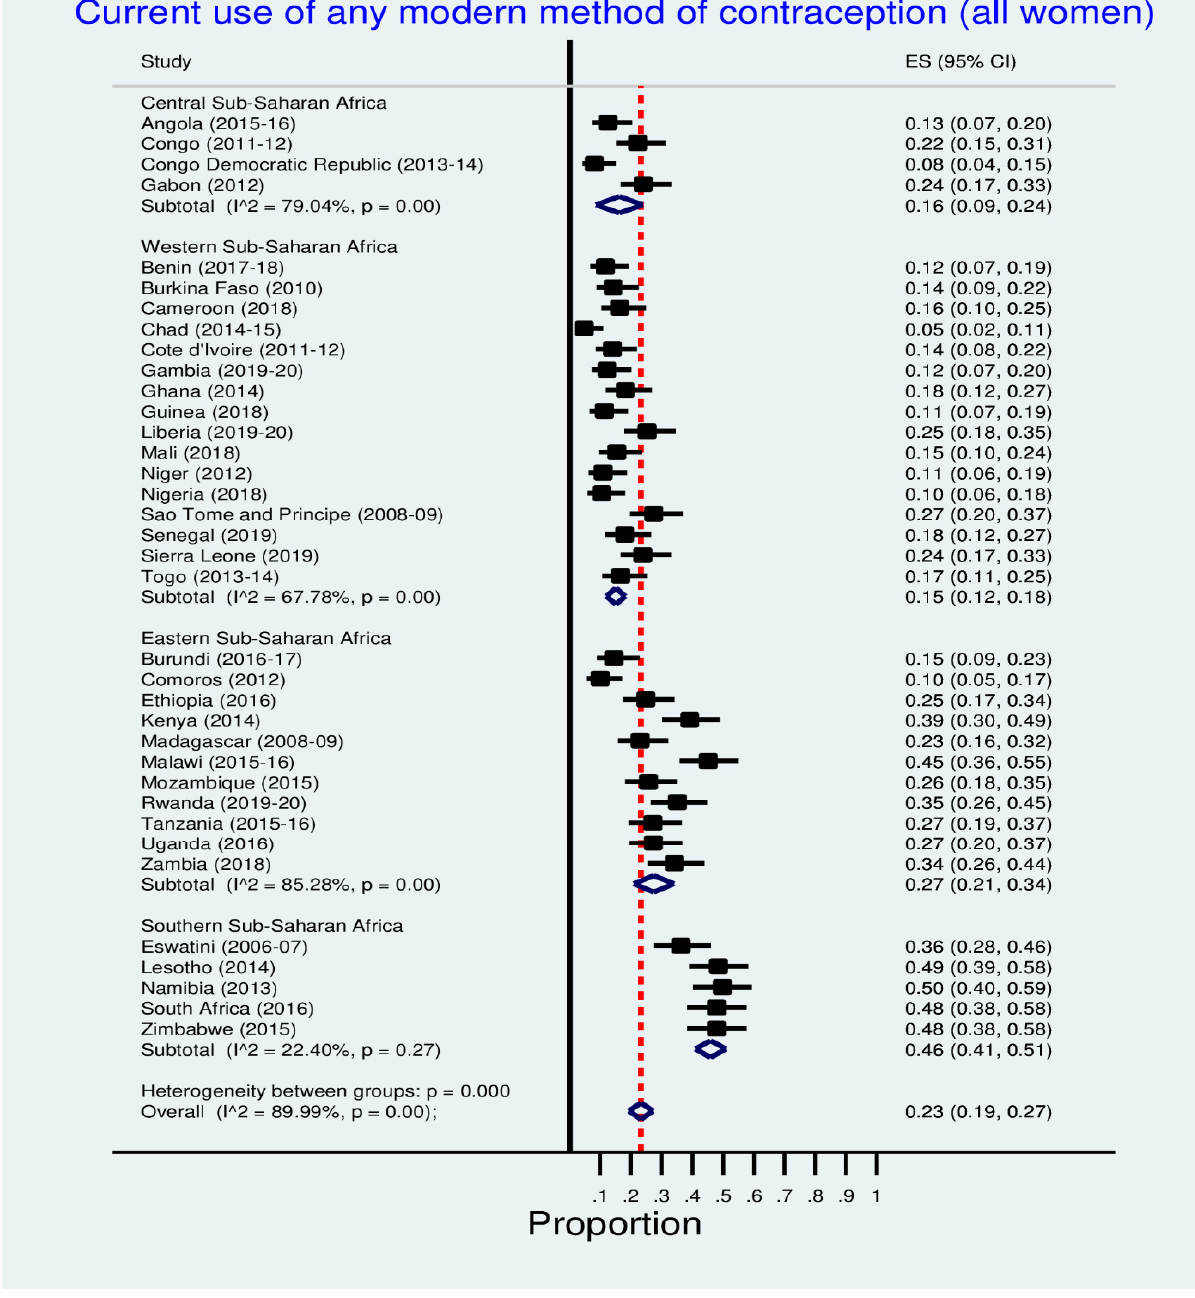
Figure 1. Prevalence of current use of any modern method of contraception (all women).